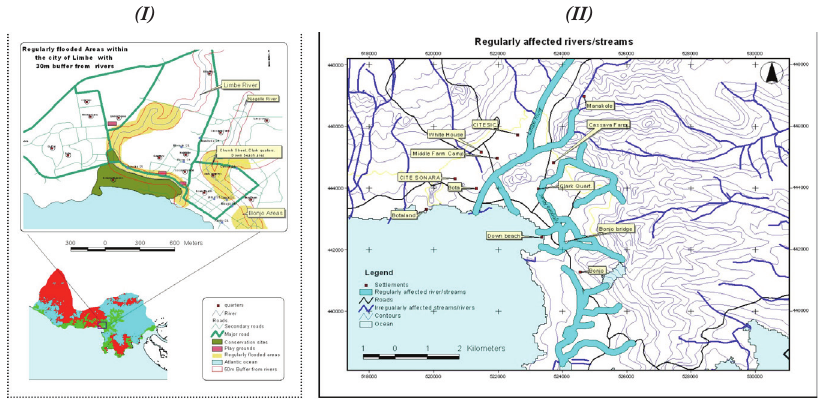
Geographic Information Systems Based Demarcation of Risk Zones: toward Risk Reduction. Figure 4-I and II: Seasonal flooded areas within the city of Limbe and regularly inundated riv- ers and streams during raining